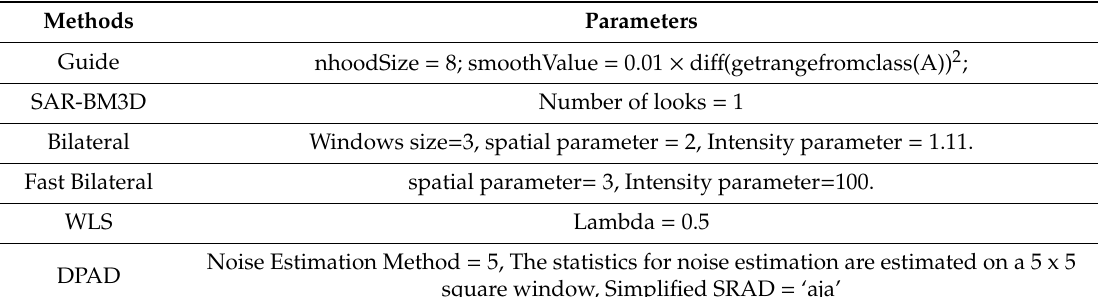
Table 9. The parameters of di ff erent filters used in this comparison.